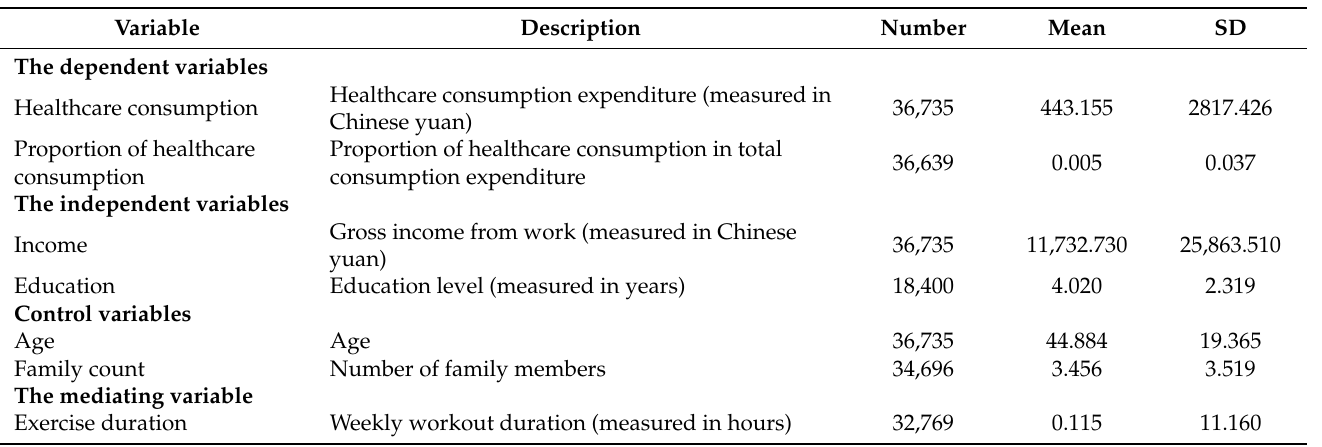
Table 1. Descriptive statistical results of continuous